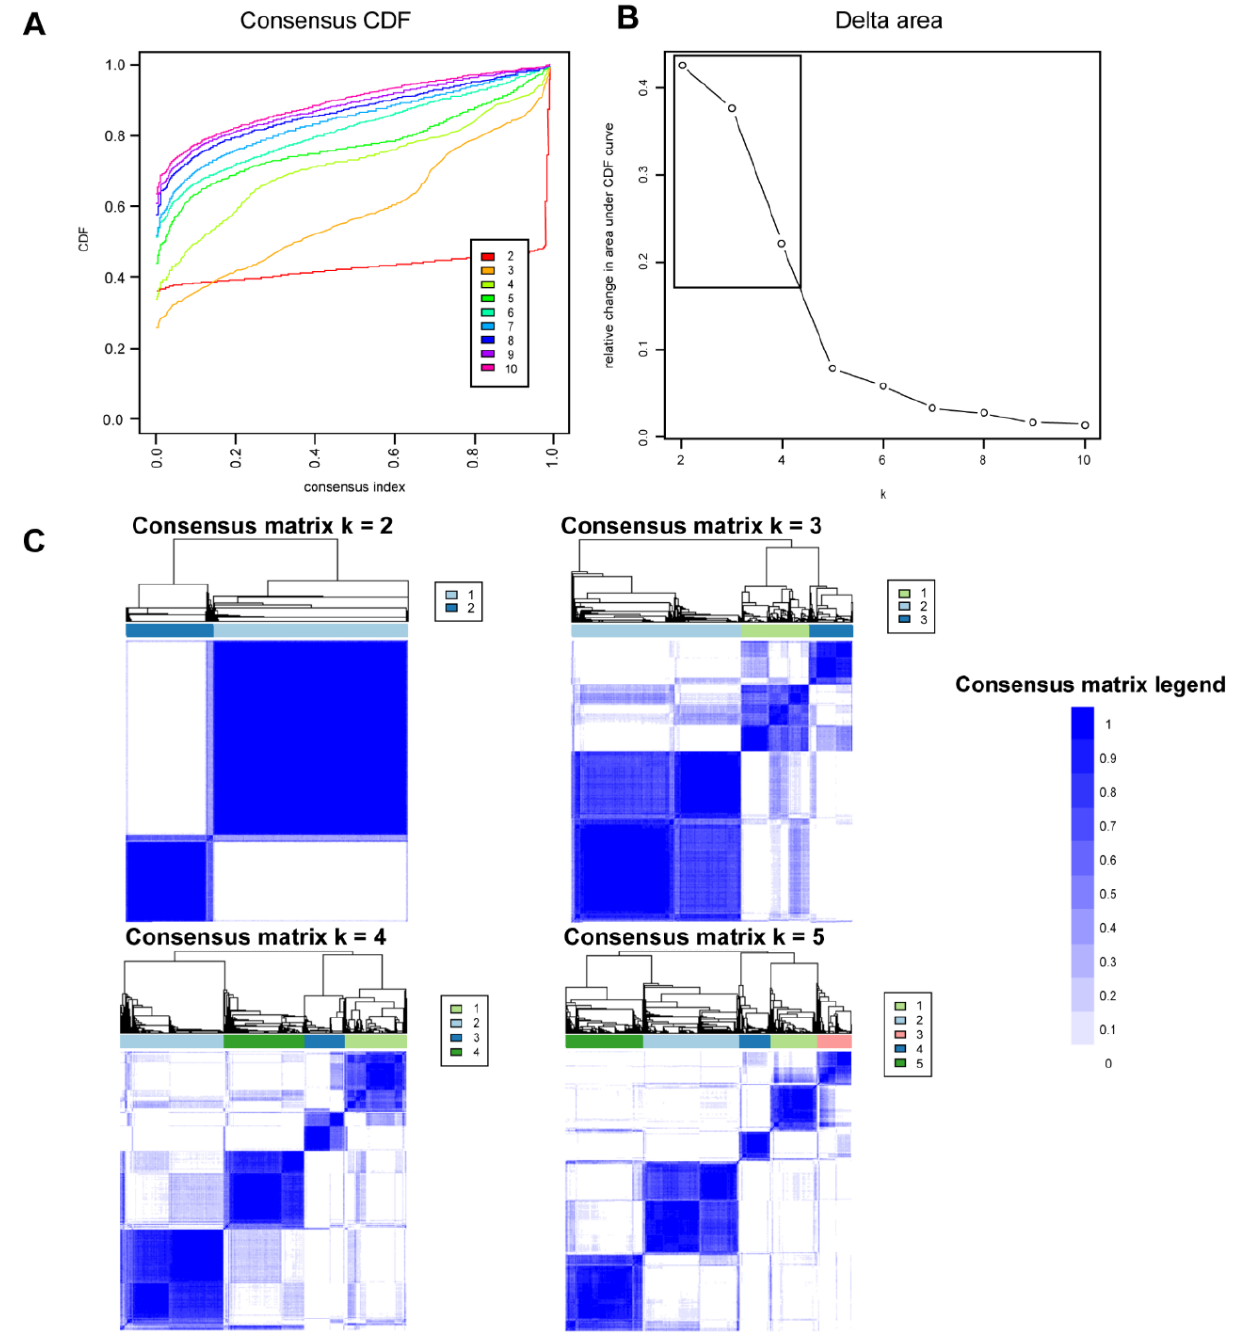
Figure 1. ( A ) CDF plot displaying consensus distributions for each k. ( B ) Delta area plot reflecting the relative changes in the area under the CDF curve. ( C ) Consensus matrix heat map depicting consensus values on a white to blue color scale of each cluster.